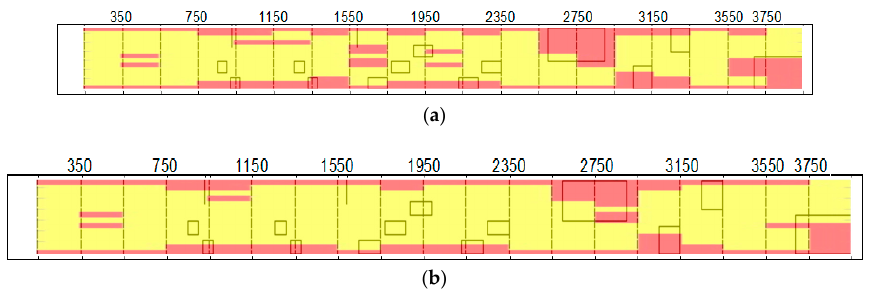
Figure 9. ( a ) Damage detection with 10 training points, 40 hidden layer neurons, and 1000 iterations and ( b ) automated cutoff value only.